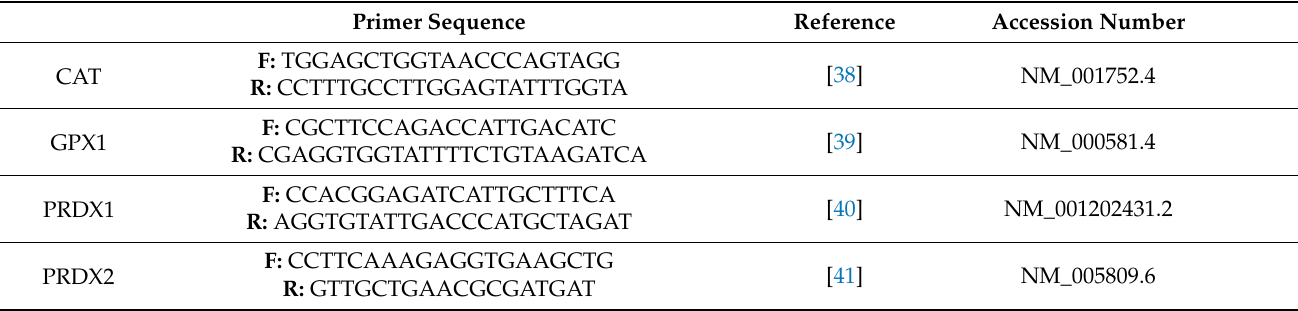
Table 1. Primers used for qRT-PCR characterization of NSCLC